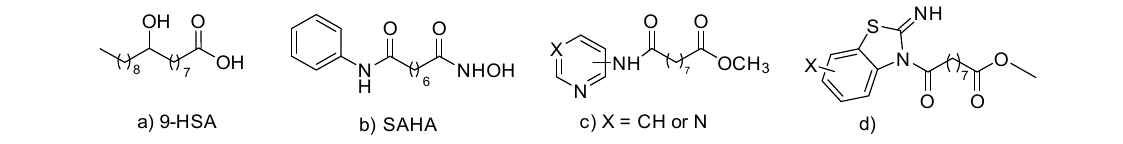
Figure 1. Structure of SAHA ( a ), 9-has and ( b ) Aza heterocycles bound to azelayl moiety ( c , d